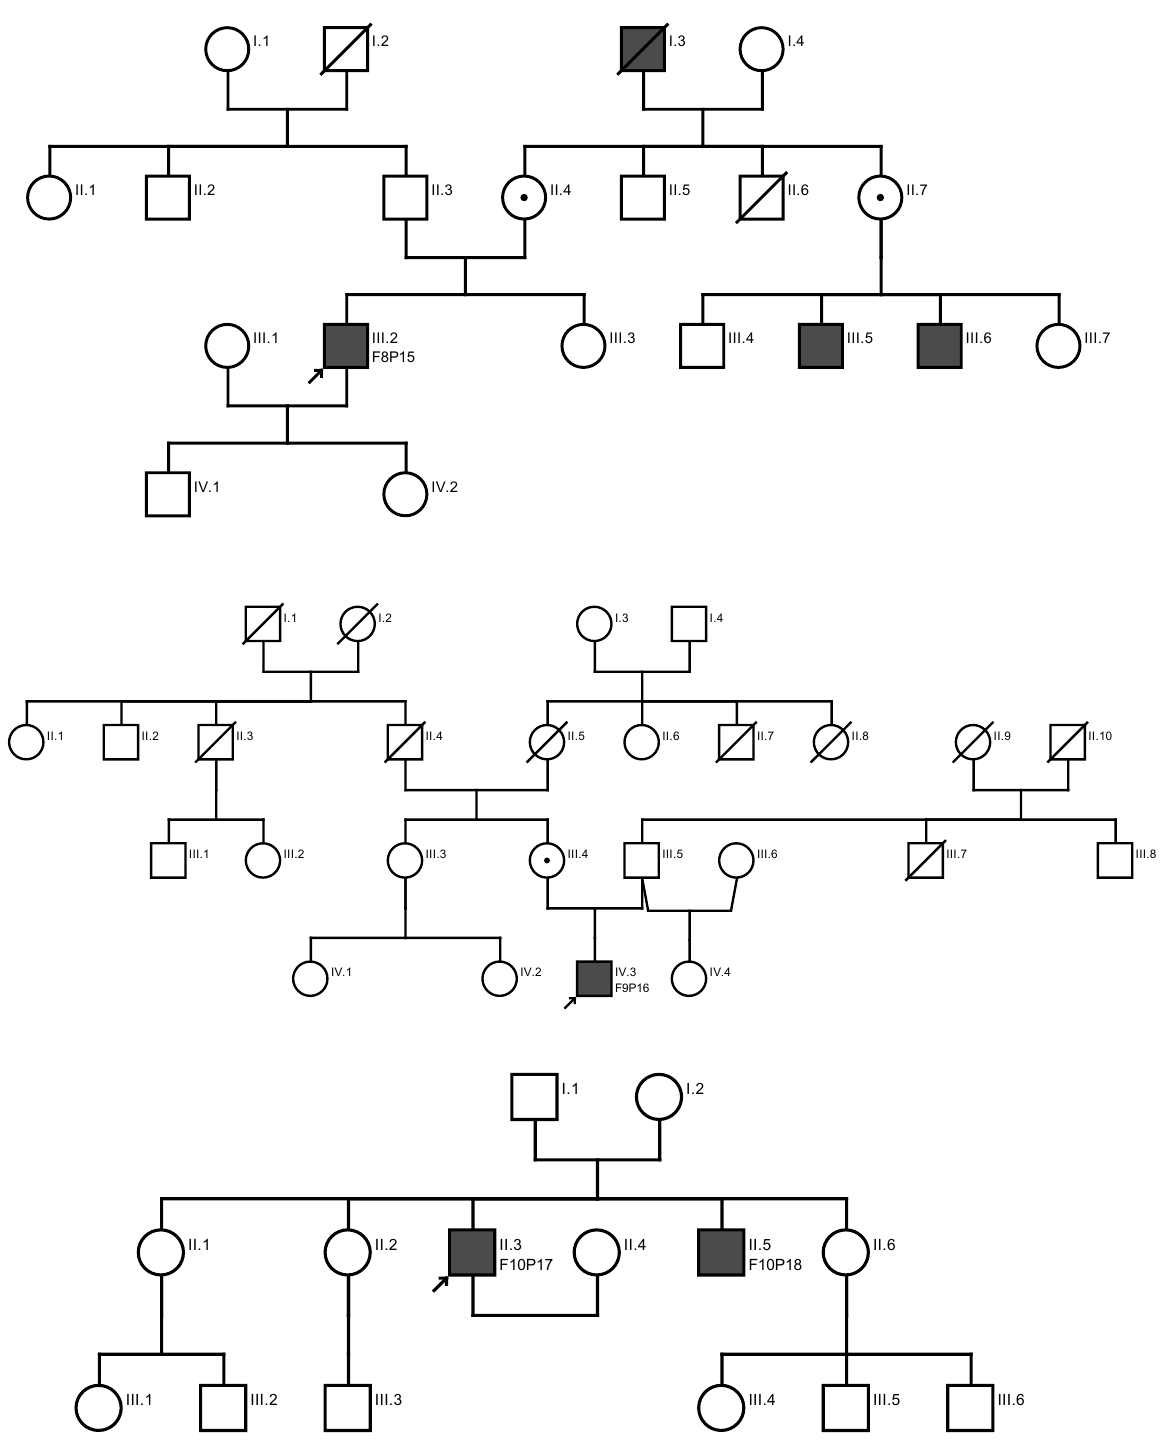
Scheme 1. Pedigrees of families and patients included in our study arranged from Family 1 to Family 10. The probands are marked with arrows. For information on identified variants and the